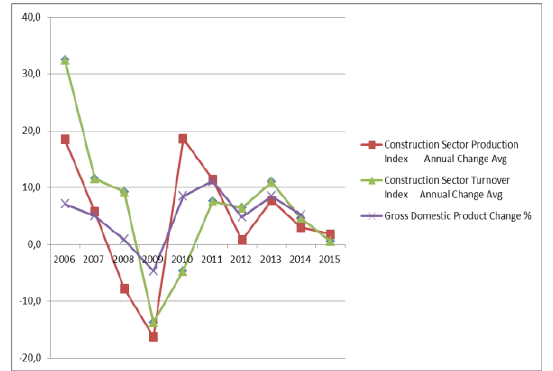
Figure 2. Comparison between Gross Domestic